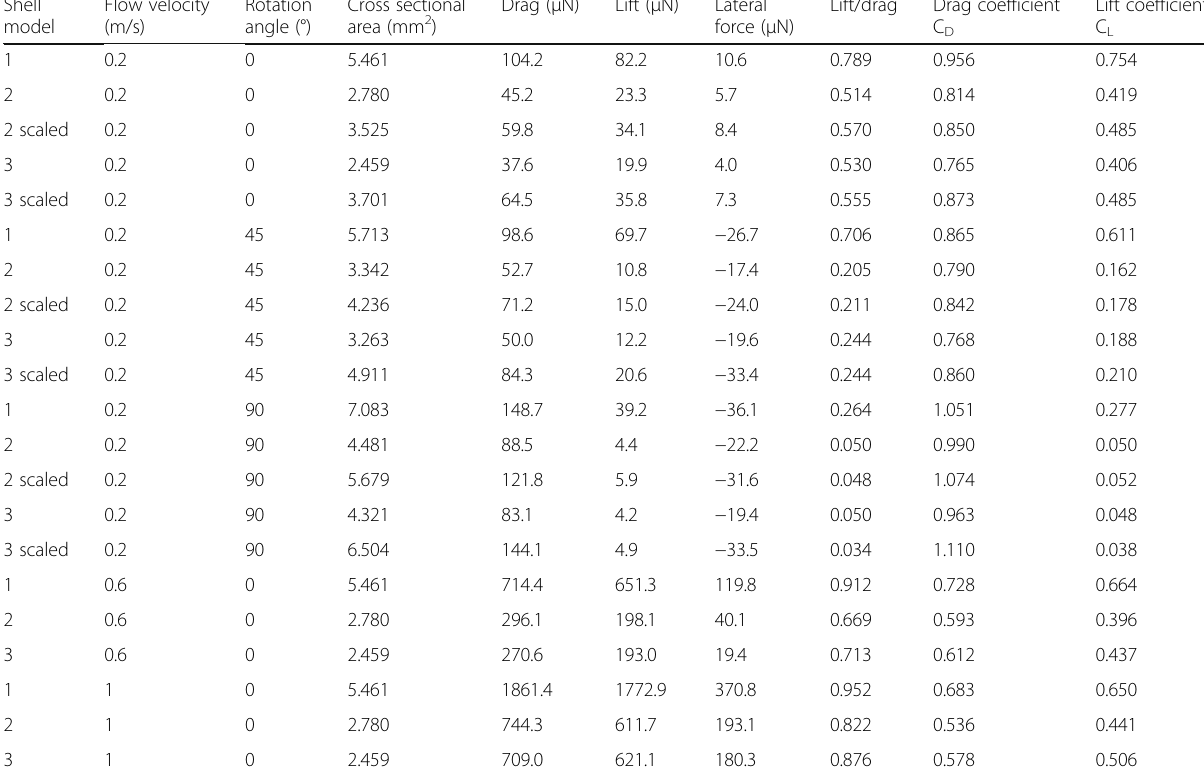
Table 2 Results from the computational fluid dynamics simulations Shell